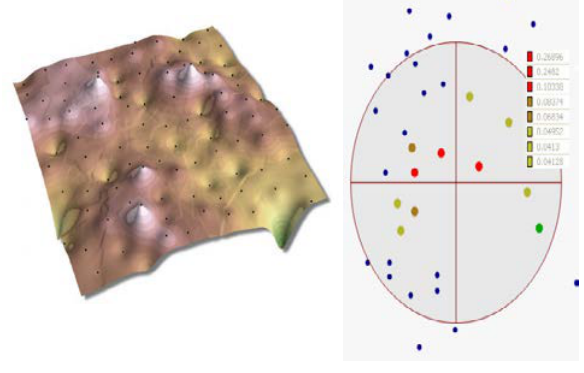
Figure 6. Example of IDW( ArcUser, 2004)